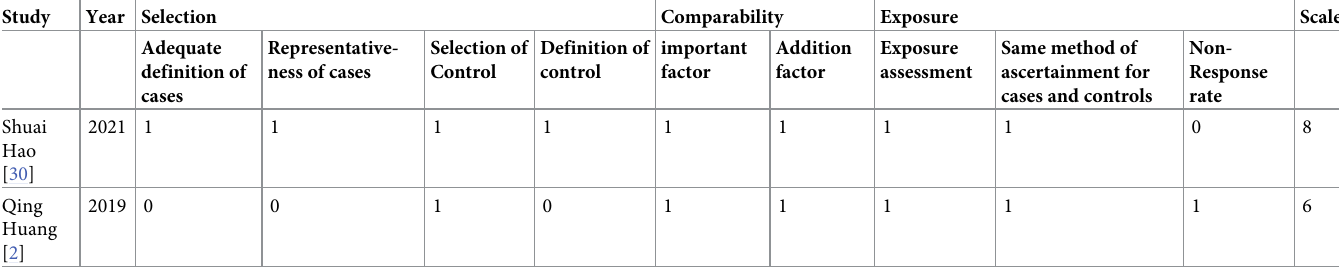
Table 3. Newcastle–Ottawa scale to evaluate the methodological quality of case-control studies included in the systematic